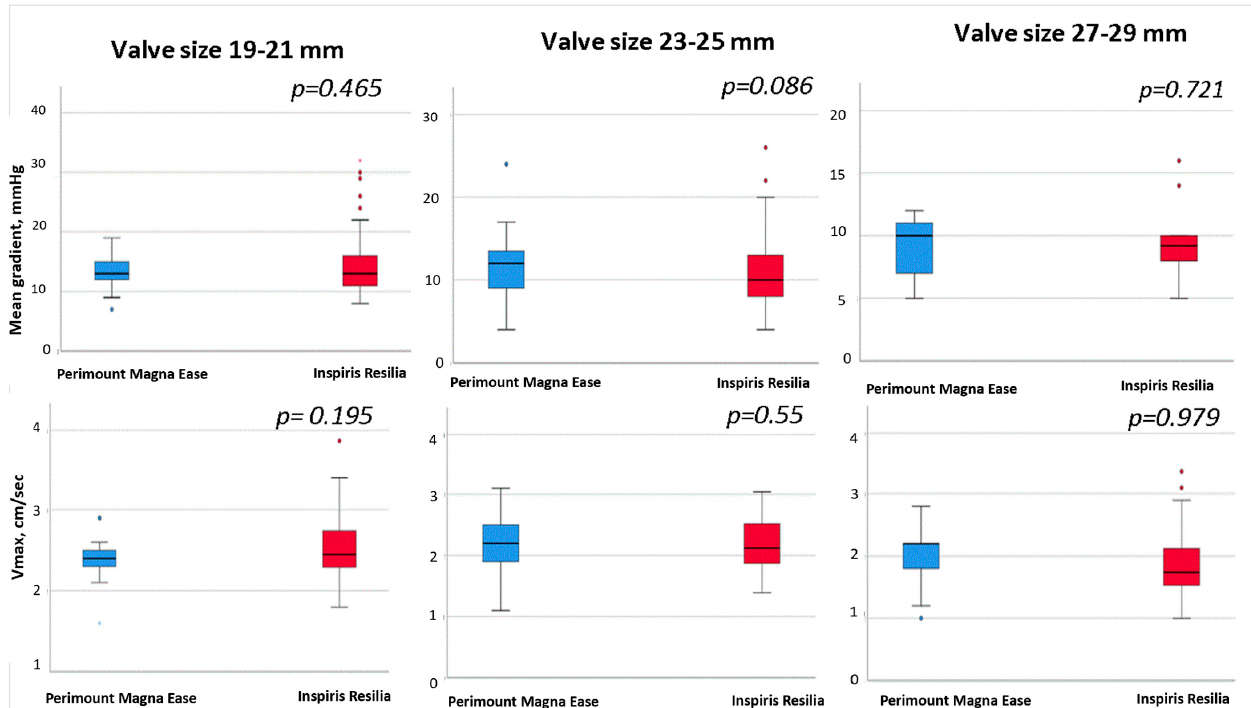
Figure 2. Perimount Magna Ease versus Inspiris Resilia prostheses: Gmean and Vmax compared by size-category (small: 19–21 mm; medium: 23–25 mm; large: 27–29 mm).